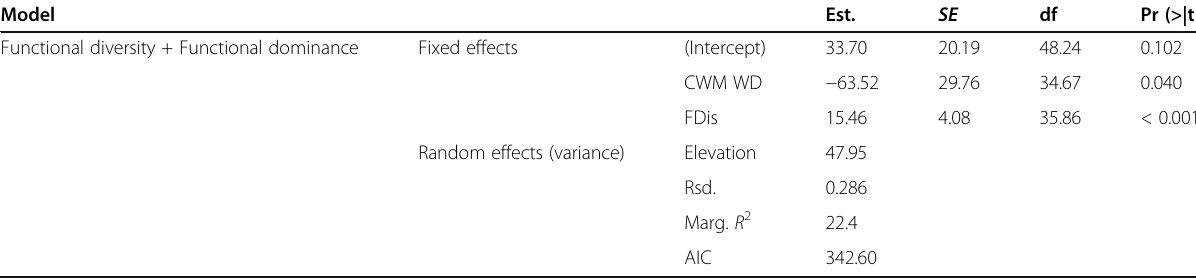
Table 5 The combined effects of functional diversity and functional dominance on AGC stock Model